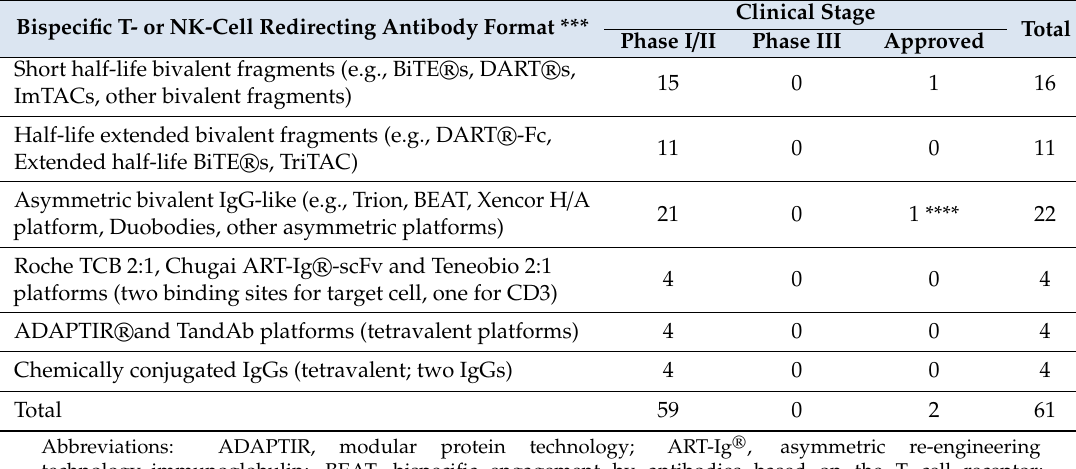
Clinical Stage Clinical Stage Phase I / II Phase III